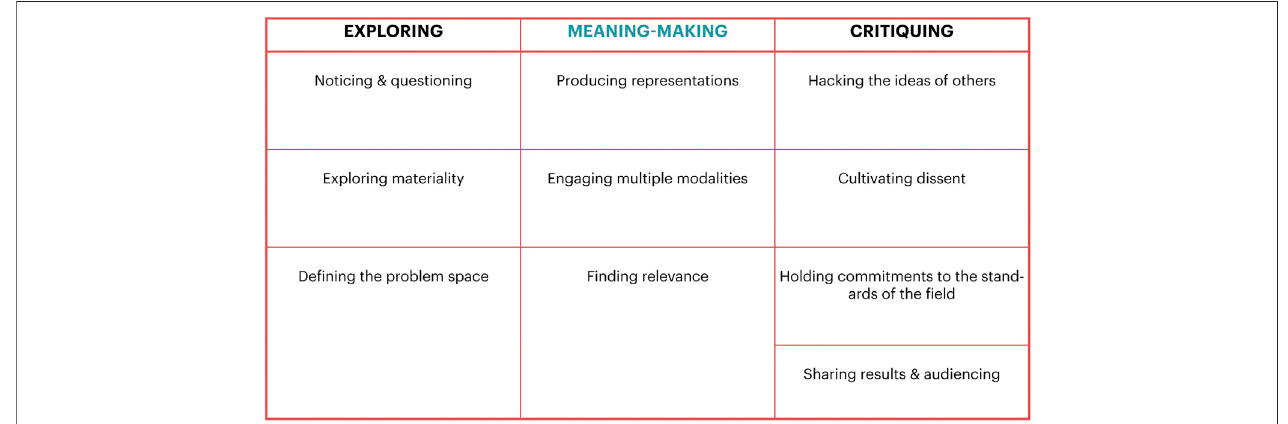
FIGURE 1 | Framework for using zines as a STEAM learning and re fl ective tool. Adapted from (Mejias et al.,